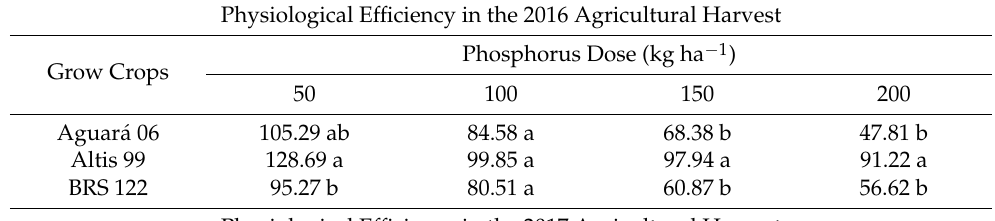
Table 2. Mean values for physiological efficiency as a function of sunflower cultivars within phos- phorus doses in the 1st agricultural harvest.